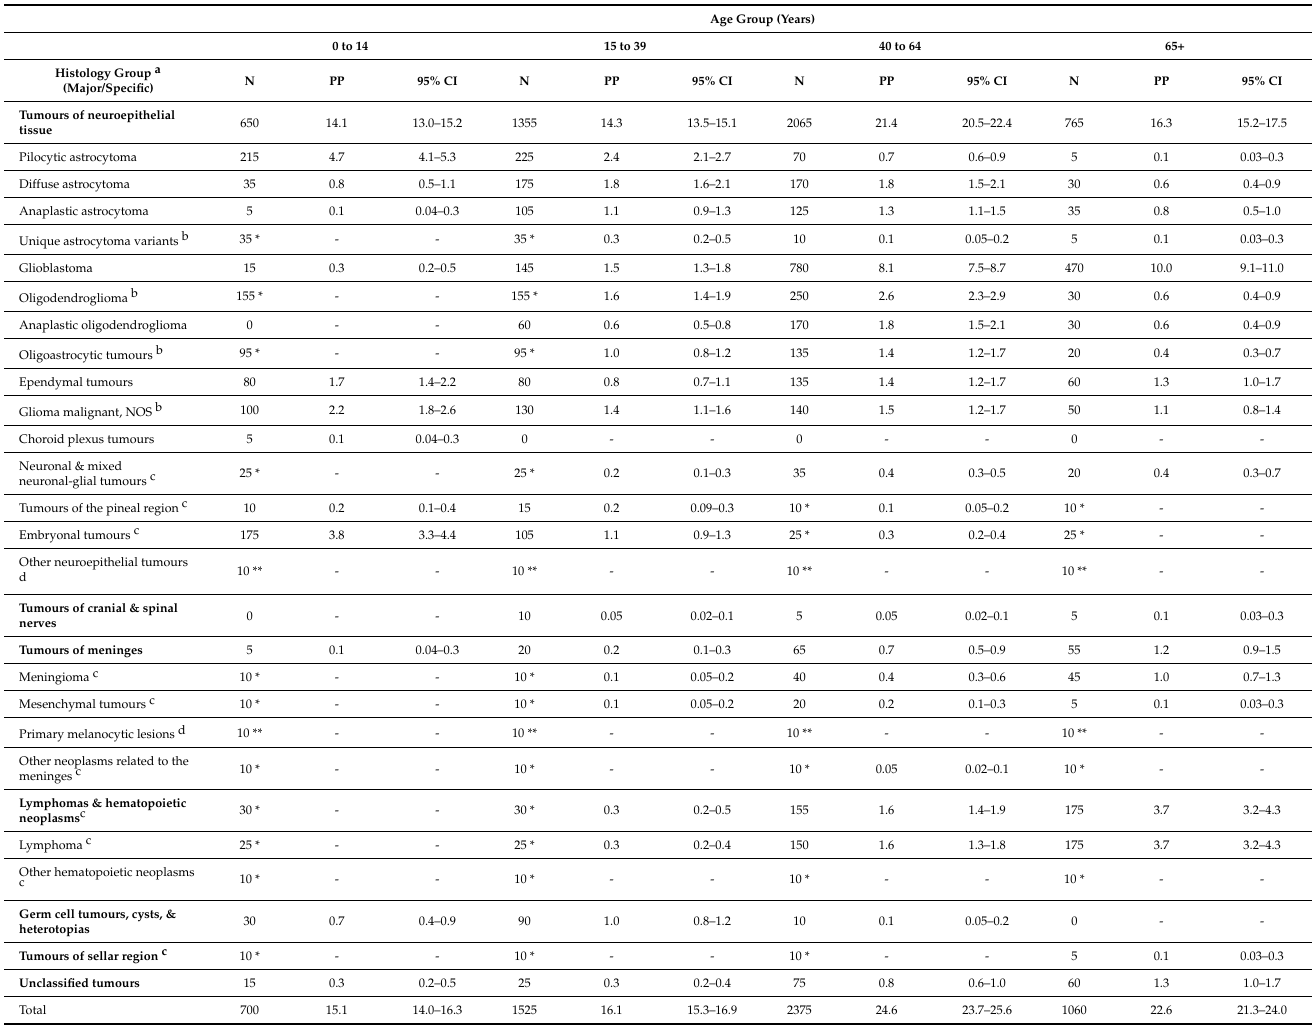
Table 5. Person-based eight-year limited-duration prevalent cases (N), prevalence proportions (PPs, per 100,000 persons), and associated 95% confidence intervals (CIs) for primary malignant CNS tumours by histology and age group as of 1 January